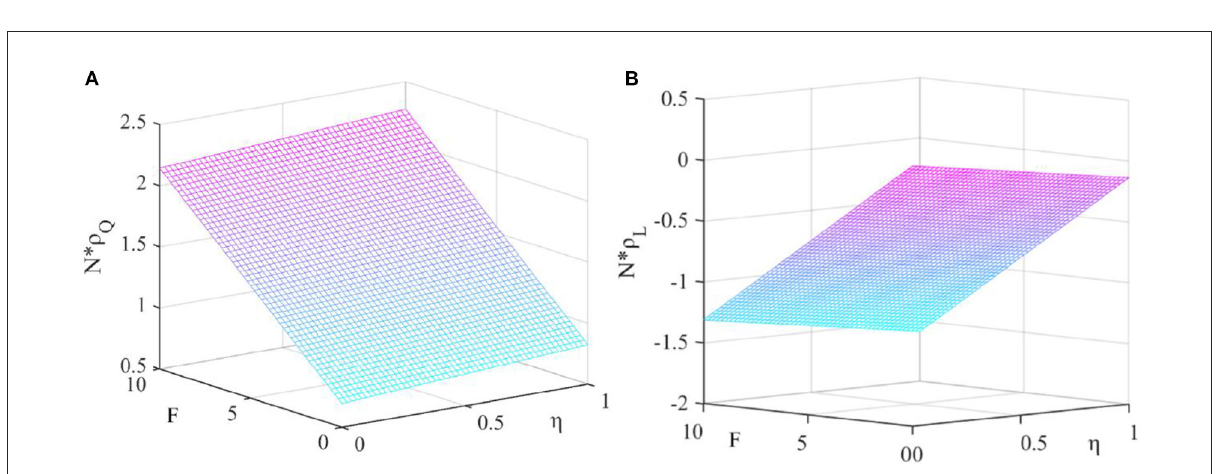
FIGURE3 Effect of government penalty and new media influence. This figure shows the effect of the government penalty and the new media influence on the fixed-point probability under the dominance of external factors. (A) Fixed point probability N × ρ Q , (B) Fixed point probability N × ρ L